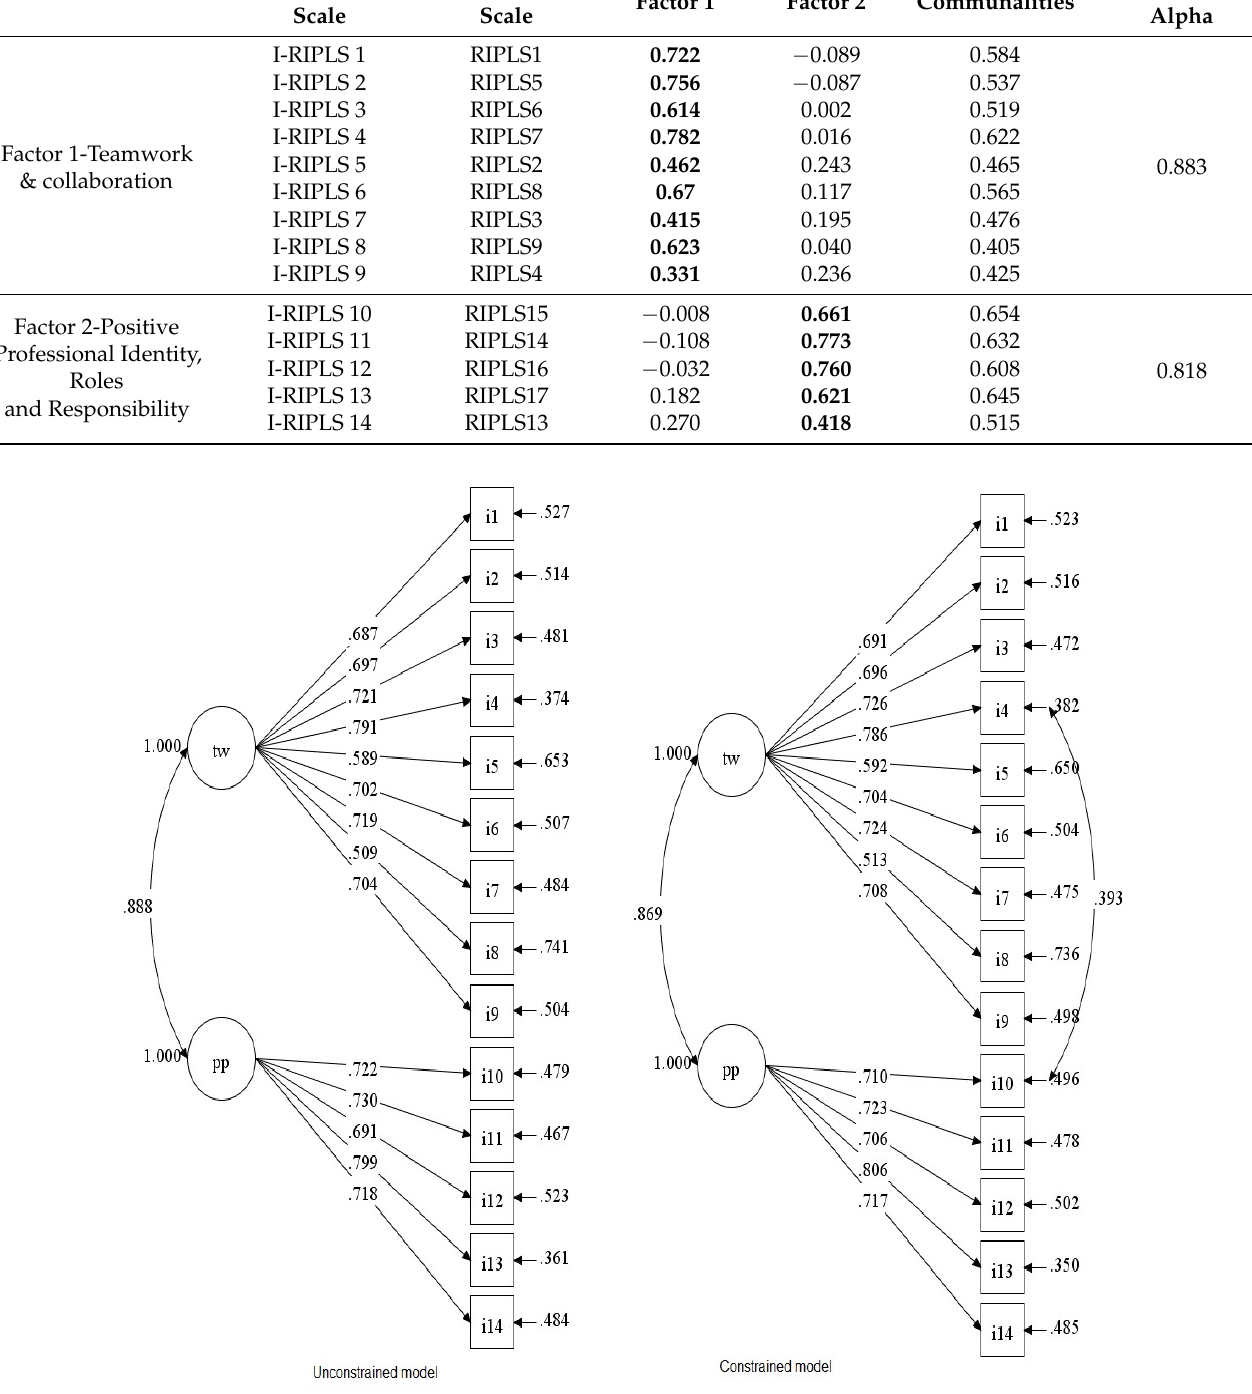
Figure 2. Unconstrained and constrained CFA models.